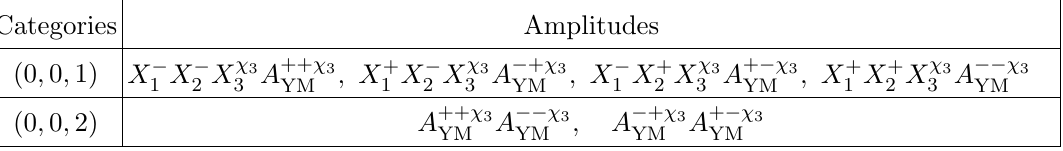
Table 3 . Truncation of List(+ (cid:0) ; + (cid:0) ; (cid:31) 3 (cid:31) 3 ).